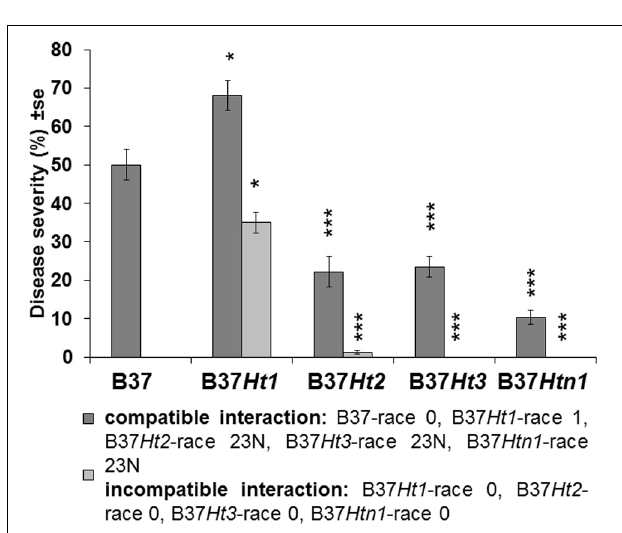
FIGURE 3 | Disease severity and standard error for compatible and incompatible interactions between Exserohilum turcicum and the maize lines B37 without resistance genes and with resistance genes Ht1, Ht2, Ht3, and Htn1 . Disease severity was evaluated 14 days post inoculation (dpi). Ten plants were evaluated per treatment ( n = 10 plants). Data from the first replication experiment are presented in the graph. Data from each line with resistance genes was compared with B37 by Mann–Whitney- U test (* p ≤ 0.05, ** p ≤ 0.01, and *** p ≤ 0.001).